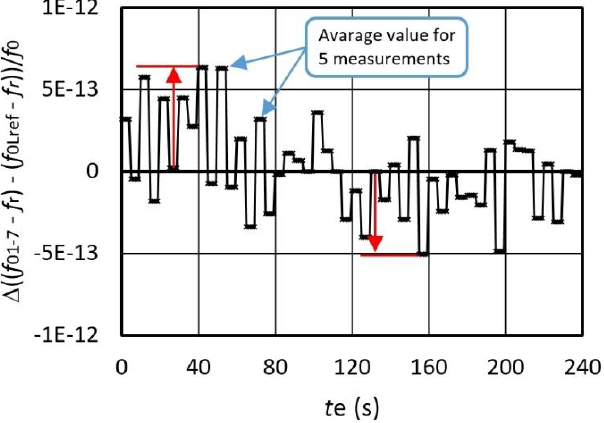
Figure 9. Output frequency variation of f out = (( f 01-07 − f r ) − ( f 0Lref − f r ))/ f 0 during the change of temperature from 0 to 50 °C ( L n = 95.01μH, L ref = 95 μH).